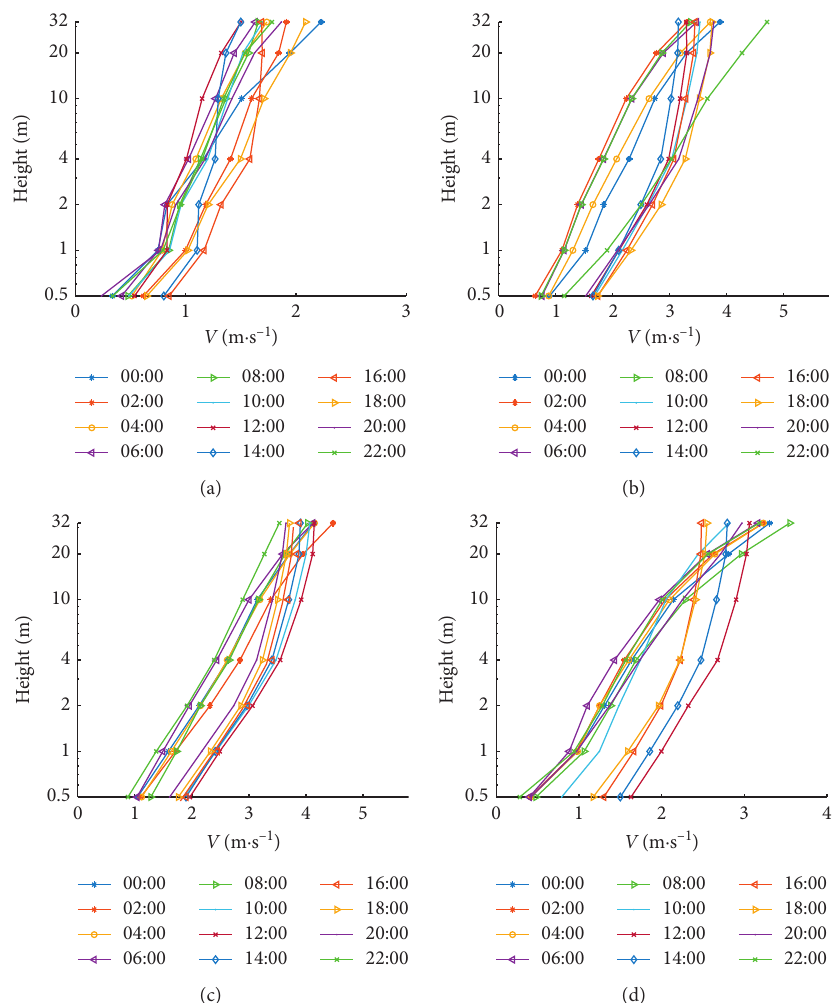
Figure 3: Wind profiles on sunny day under the four underlying surface conditions in the Gurbant¨ungg¨ut Desert. (a) Winter. (b) Spring. (c) Summer. (d)